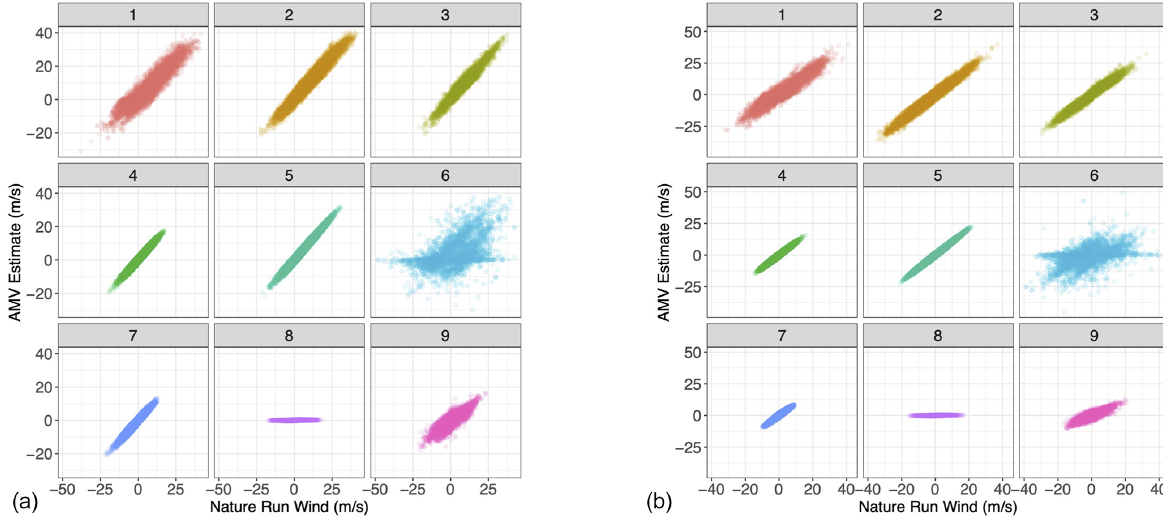
Figure 6. Scatterplot of simulated Nature Run wind vs. AMV estimates, each sub-panel corresponding to the specific Gaussian mixture component to which each point in the testing set has been assigned. (a) u -direction wind; (b) v -direction wind.